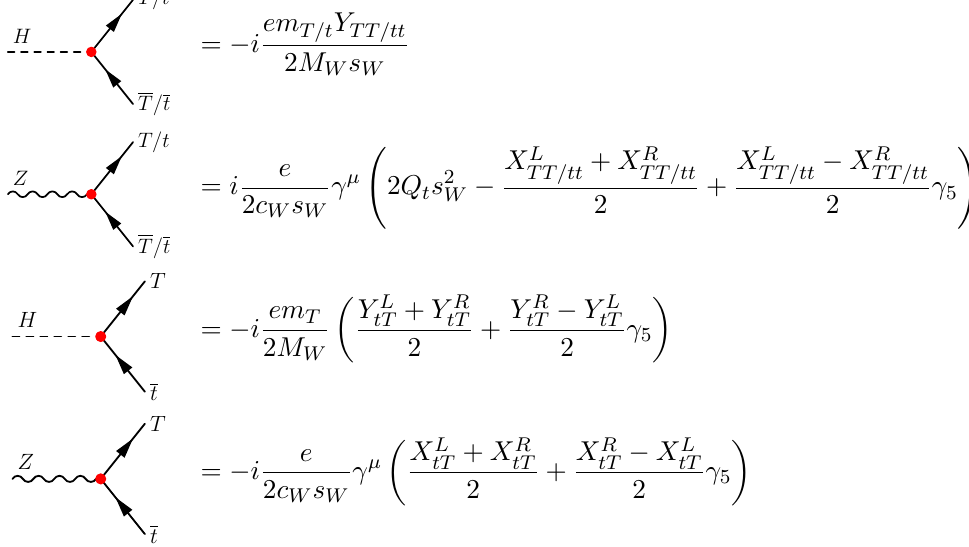
Figure 11 . Feynman rules for the Higgs and Z couplings due to a vector-like T quark calculated with FeynRules [80,